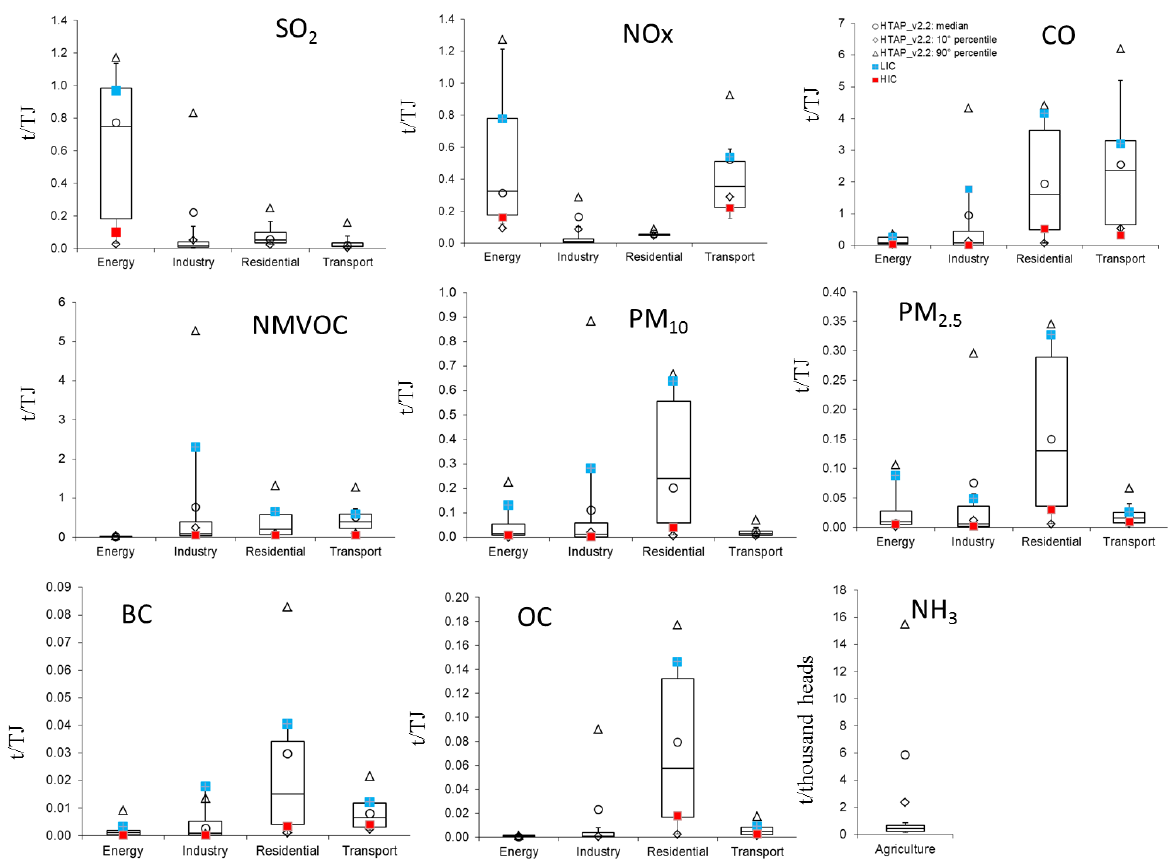
Figure 7. Implied emission factors calculated for 226 countries for the aggregated emission sectors (energy, industry, residential, transport, and agriculture) from the EDGAR v4.3.2 database. Box-plot statistics (10th, 25th, 50th, 75th, and 90th percentile) represent the country variability of the implied EFs in 2010. The comparison with the corresponding implied EFs obtained for the HTAP v2.2 (Janssens-Maenhout et al., 2015) emission data, which excludes agricultural waste burning and field burning, is also reported. In addition, we report the median of low-income and high-income countries (with light blue and red makers, respectively) for the sectors showing the larger variability across countries. Table S1 of the Supplement reports implied EFs for all pollutants and sectors for selected regions differing in income level and the comparison with the global